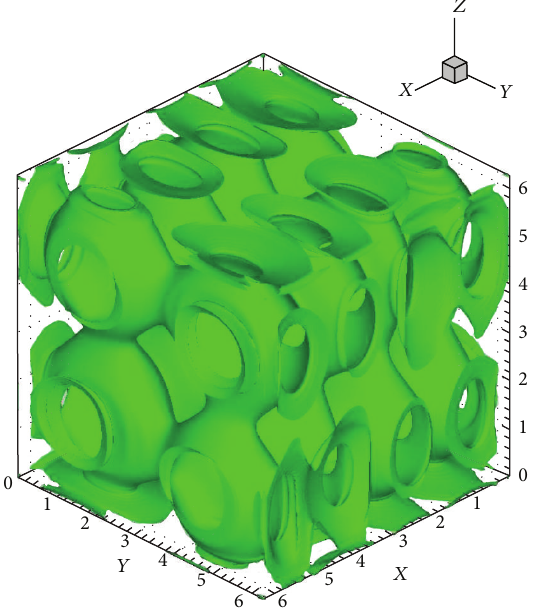
Figure 12: Instantaneous surface plot of the divergence of the magnetic field ( ∇⋅ B ) on all the 𝑍 -surfaces at 𝑡 = 0.5 for the solution of the Orszag-Tang system.